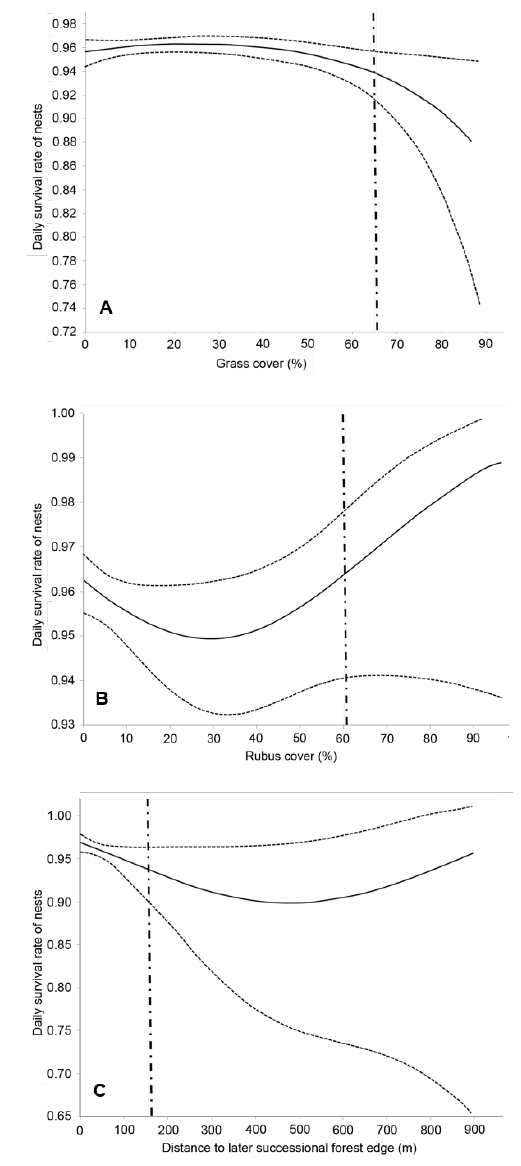
Fig. 3 . Relationships (± 95% CI, dashed lines) between (A) grass and (B) Rubus cover within 1 m and (C) distance to a later successional forest edge and daily survival rate (DSR) of Golden-winged Warbler ( Vermivora chrysoptera ) nests, based on models with substantial support from Model Suite III (A = DSR [State + grass cover + grass cover2], B = DSR [State + Rubus cover + Rubus cover2], C = DSR [State + edge distance + edge distance2]). DSR remained relatively constant until grass cover reached 50%, after which DSR declined (A). DSR was lowest at about 30% Rubus cover (B). DSR had a negative association with distance to a later successional forest edge (C). Almost all (95%) of the nests had < 64% grass cover and < 60% Rubus cover within 1 m and were < 152 m from a later successional forest edge (vertical